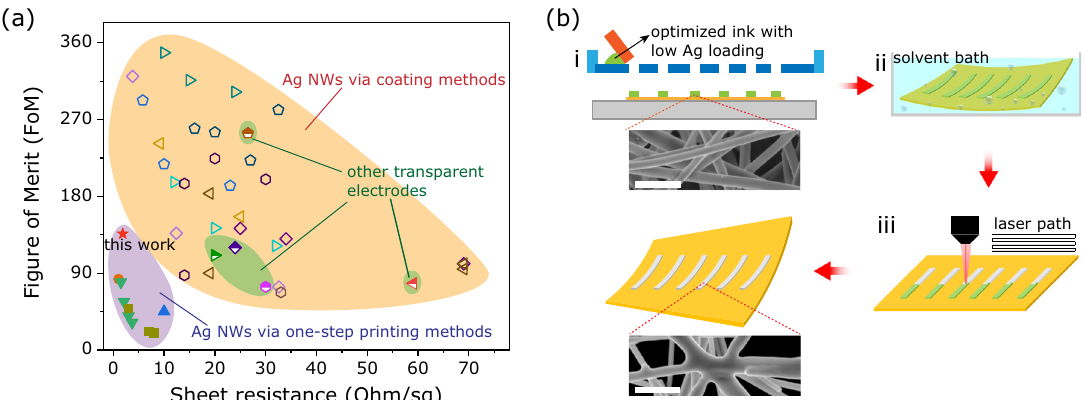
Fig. 1 a Plotting of the FoM as a function of the sheet resistance of the conductive Ag NW fi lms via various coating methods (ground color of yellow) ( fi ltration, 8,57 drop coating, 30 spin coating, 32 spray coating, 43 and Mayer rod coating 13,31 ) and one-step printing methods (ground color of purple) (electrohydrodynamic printing, 49 additive printing, 58 screen printing, 25 inkjet printing, 34 and seed particle printing 59 ), as well as some other transparent conductors (ground color of green) through direct writing of silver nanoparticles (Ag NPs), 60 copper random network, 61 direct printing of Ag precursors, 50 and laser transferring. 51 Note: For the printed Ag NW patterns in the literature, where the transmittance values at the wavelength of 550 nm are not clearly mentioned, the FoMs have been estimated based on the fi lm thicknesses and the physical appearance of the patterns in comparison to our work. b Schematics for the process to achieve high transparency and conductivity for the printed Ag NW fi lms in this work. (i) Optimization of ink formulation and printing parameters to tune the transparency of the printed Ag NW fi lms. (ii) Immersion of the printed fi lms in a solvent bath to recover the conductivity. (iii) Treatment with strong laser to further increase the conductivity and transparency. The Ag NWs are loosely contacted after printing as shown in the scanning electron microscope (SEM) image in (i), whereas they are completely connected after laser treatment. The scale bars are 500